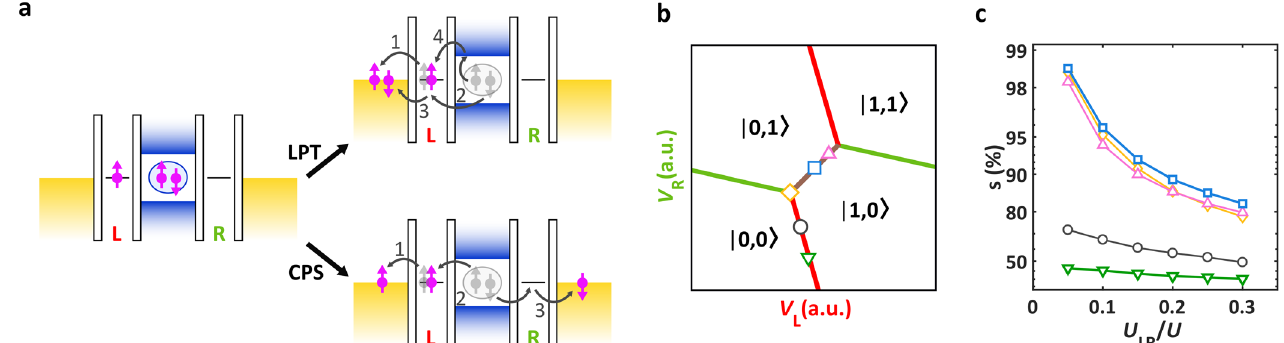
Fig. 4 Transport modeling. a A possible sequence of LPT and CPS. The arrows with the numbers indicate the event order in the sequence. Electrons in gray symbolize the initial occupations, while the purple ones belong to the fi nal states. b Sketched phase diagram of the honeycomb presenting the border of ground state occupations of both QDs simultaneously. By crossing the red (green) line, the electron number is changed on the left (right) QD. c U LR / U dependence of s calculated in different points of the stability diagram, indicated by markers in panel ( b ). While a decreasing tendency of the CPS contribution to the total current can be observed throughout the phase diagram, the ef fi ciency is maximal in the middle of the 1 ; 0